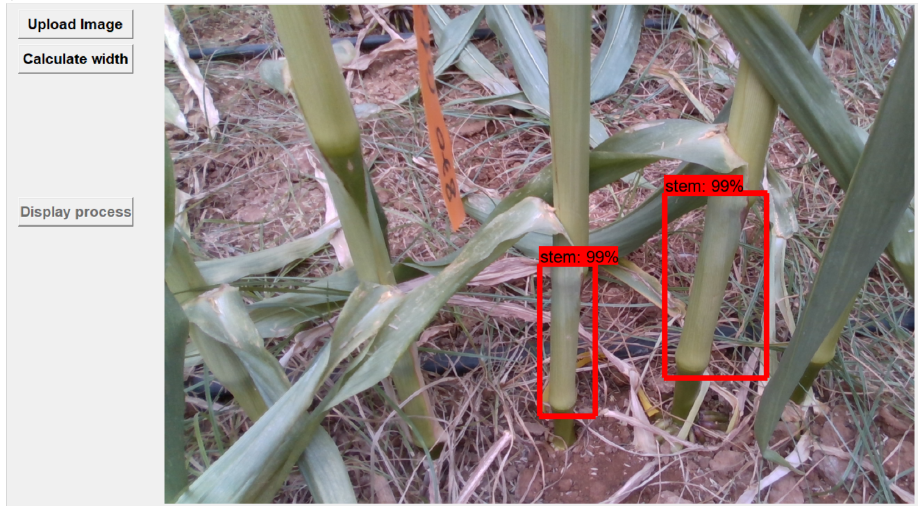
Figure 12. Detected stems in the image uploaded to the width estimation